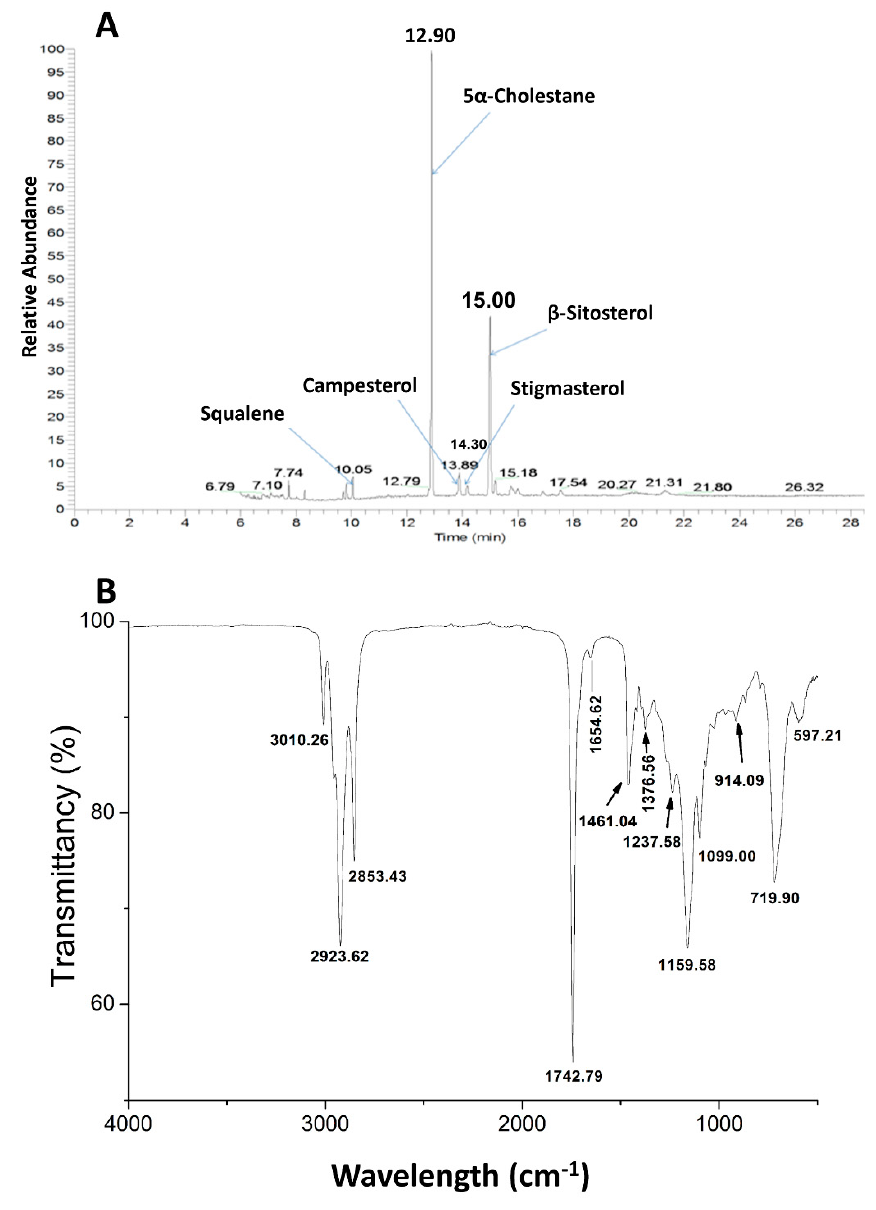
Figure 1. ( A ) Sterols in Mexican chia seed oil were analyzed using a gas chromatograph-mass spectrometer system by standards. (tR = 10.05 min), squalene; (tR = 12.90 min ), 5- α -cholestan; (tR = 13.89 min), campesterol; (tR = 14.30 min ), stigmasterol; (tR = 15.00 min), β -sitosterol. ( B ) FTIR spectra for chia seed oil extracted.